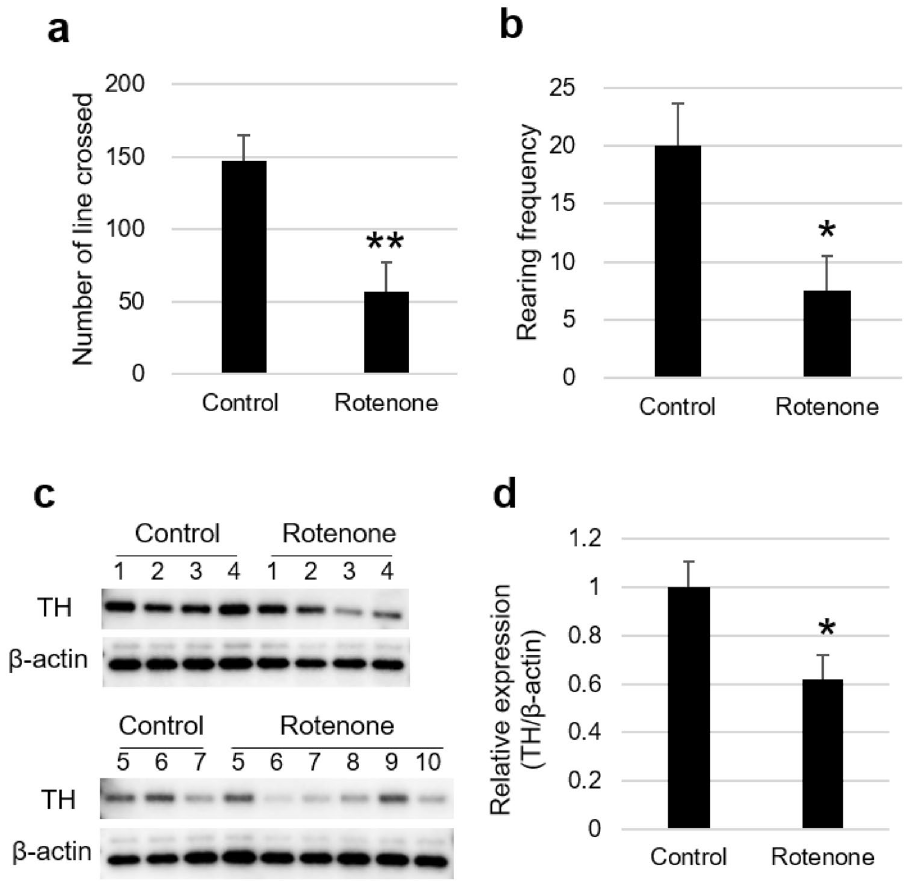
Figure 1. Pathological analysis of control rats (n = 7) and rotenone-administered Parkinson’s disease model rats (n = 10). ( a ) Number of lines crossed and ( b ) frequency of rearing in an open field test. ( c ) Expression levels of TH and b-actin in the rat striatum were analyzed via immunoblotting analyses. ( d ) Relative expression levels of TH were evaluated via immunoblotting analysis. Values are presented as the mean ± standard error of the